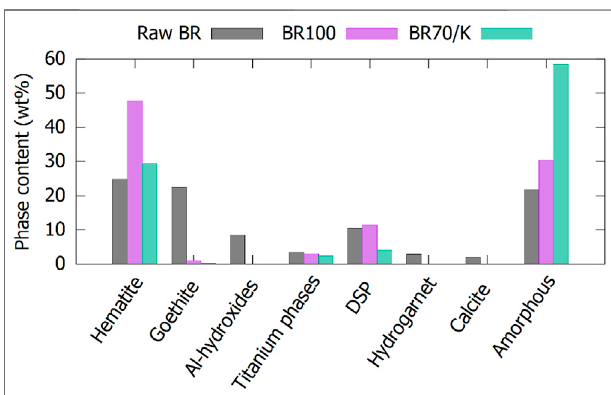
FIGURE 2 | Quanti fi cation of the major phases in raw, calcined, and co- calcined BRs. The results are averaged over the eight different origins of the BRs. Only the crystalline part of the DSP and hydrogarnet is taken into